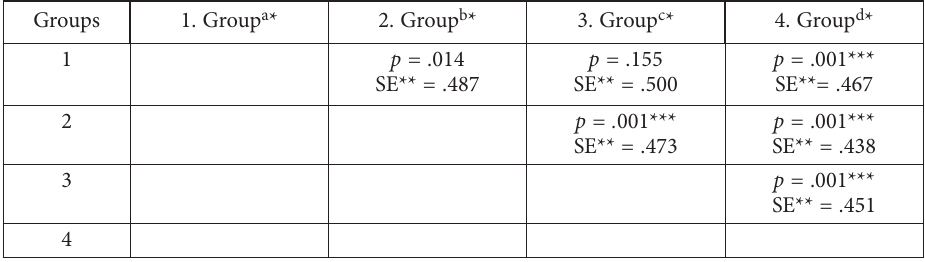
Table 3. Multiple comparisons (Tukey’s range test) of groups’ Torrance Tests of Creative Thinking scores (source: created by author) Groups